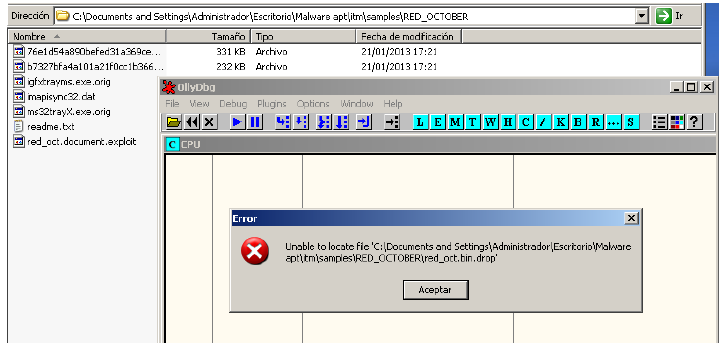
Figure 12. Identification of protection measure.